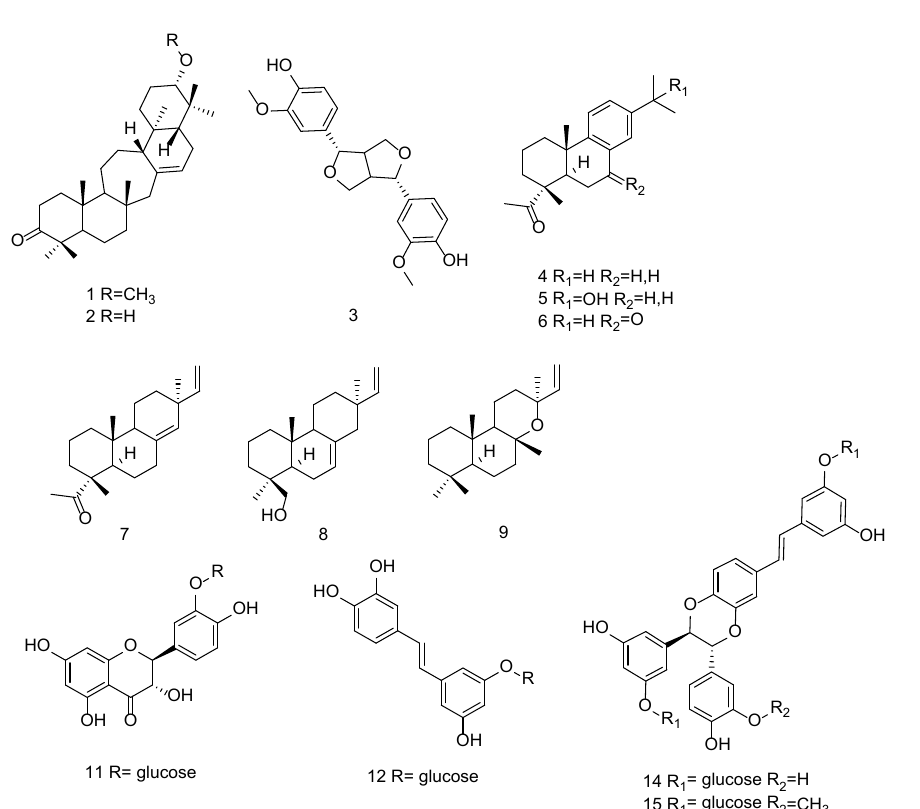
Figure 1. Chemical structures of compounds: 21 α -metoxy-serrat-14-en-3-one ( 1 ), 21 α -hydroxy-serrat-14-en-3-one ( 2 ), pinoresinol ( 3 ), dehydroabietic acid ( 4 ), 15-hydroxy dehydroabietic acid ( 5 ), 7-oxo dehydroabietic acid ( 6 ), pimaric acid ( 7 ), 9 β -pimara-7,15-dien-19-ol ( 8 ), and 13-epimanoyl oxide ( 9 ), isolated from the lipophilic extracts. Taxifolin-3’-O-glucopyranoside ( 11 ), trans-astringin ( 12 ), and piceasides G and E ( 14,15 ) were isolated from the methanolic fraction.